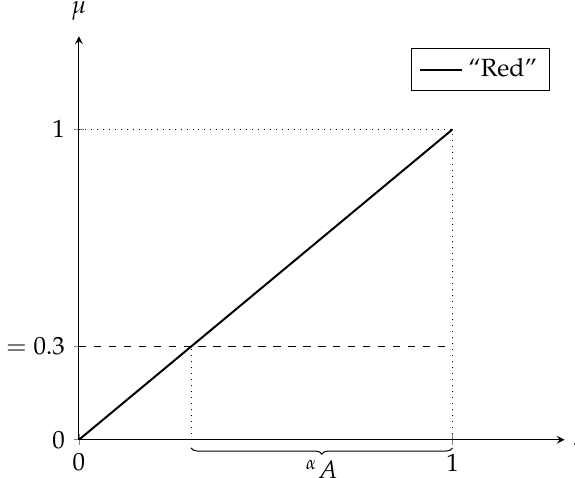
Figure 4. The fuzzy set for the value colour . Here, we display the colour Red , although the same shape applies for Green and Blue . We also demonstrate the crisp set 0.3 A .